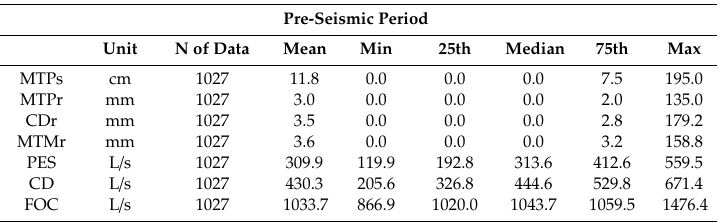
Table 3. Basic statistics of the considered time-series, related to the Pre-seismic, Co-seismic, and Post-seismic periods. See Table 1 for the monitoring points’